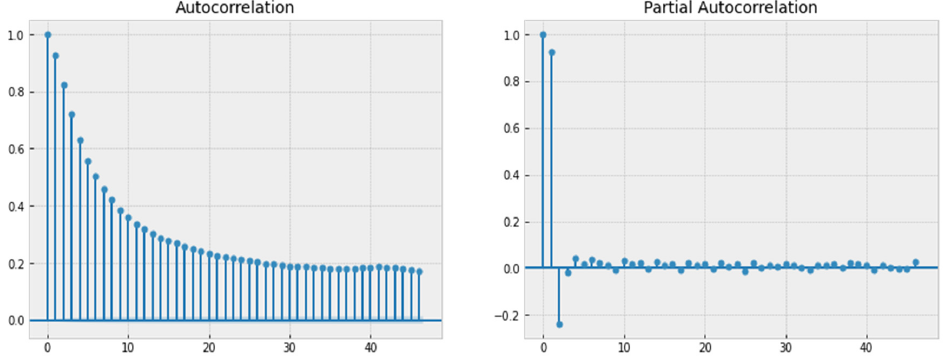
Figure 7. Wind speed autocorrelation and partial autocorrelation.